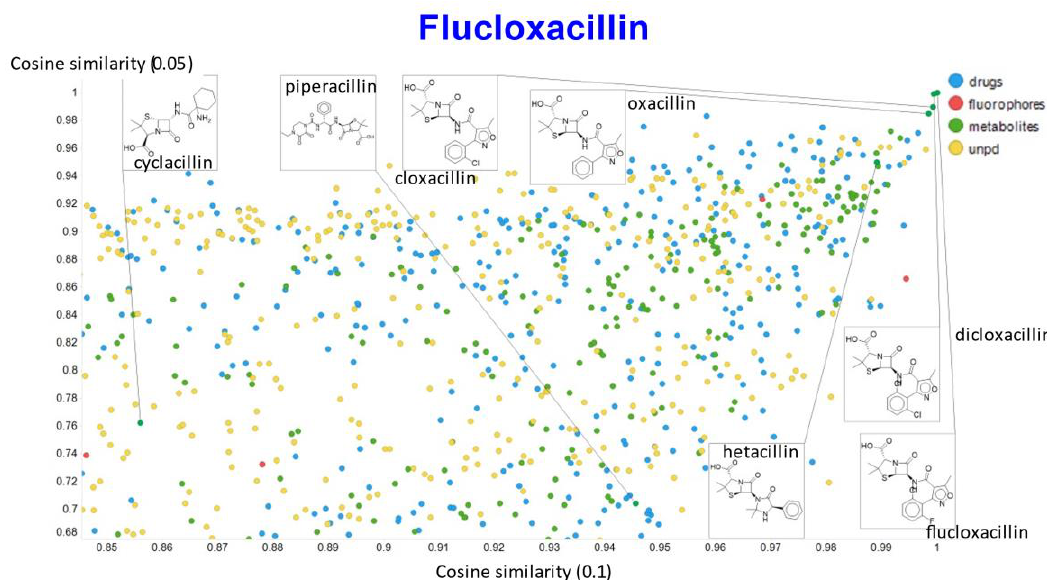
Figure 17. Relationship between cosine similarity for values of the temperature parameter of 0.05 and 0.1 for flucloxacillin in our chemical space.